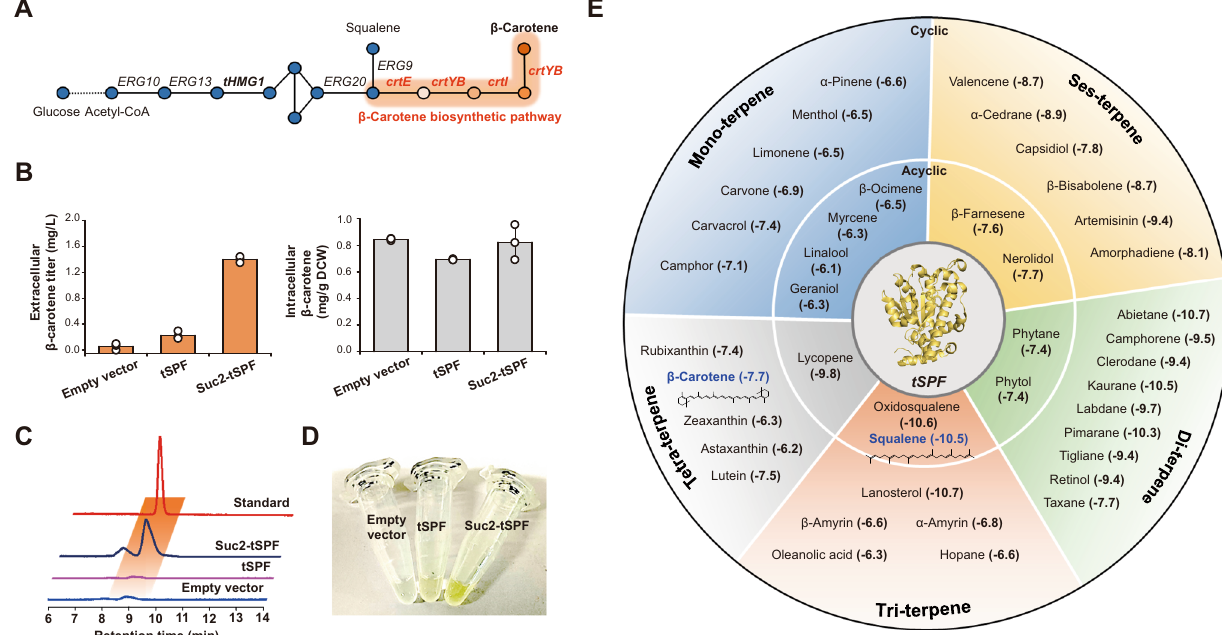
Fig. 3 Extension of our metabolite traf fi cking strategy for the secretion of other terpenes. A The biosynthetic pathway of β -carotene production. Compared to the squalene biosynthesis pathway, this pathway further involves the expression of three constitutive genes, namely crtE , crtYB , and crtI . B Quantitative measurements of secreted and accumulated β -carotene produced by the engineered strains that overexpress Suc2-tSPF. Yeast cells were grown in a de fi ned minimal medium with 2% (w/v) glucose and 10% (v/v) dodecane at 30 °C for 144 h. All data represent the mean of biological triplicates, and error bars indicate the standard deviation. C High-performance liquid chromatograms of β -carotene secreted by Suc2-tSPF. Compared to the β -carotene standard (red), overexpression of Suc2-tSPF (navy) resulted in a distinct peak at the same retention time, thus validating the extracellular secretion of β -carotene. In contrast, non-tagged tSPF (pink) failed to transport β -carotene outside cells. D Colorimetric determination of secreted β -carotene, an orange-colored terpenoid. After 144 h of cultivation, the expression of Suc2-tSPF resulted in a visible color change of dodecane due to extracellular β -carotene secretion. However, when only tSPF or no carrier protein was expressed, the dodecane phase showed faint coloration. E The binding promiscuity of tSPF towards a wide range of hydrophobic terpenes produced by microbial cells. The binding energy between SPF and each terpene predicted by molecular docking with AutoDock Vina in PyRx varied from − 10.7 to − 6.1 kcal/mol, which was comparable to the binding energy between SPF and squalene. Source data are provided in the Source Data fi